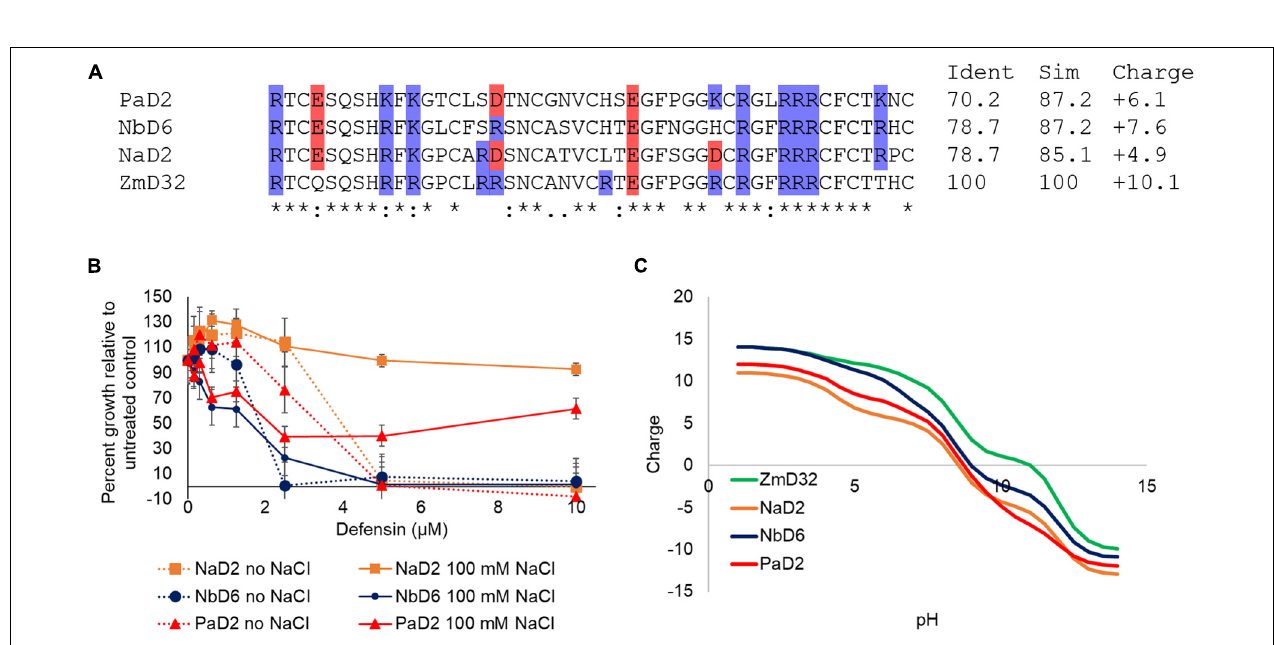
FIGURE 8 | Activity of defensins with similar sequences to ZmD32 is related to the charge on the defensin. A query of the defensins database for sequences that were highly similar to ZmD32 returned three candidates, NaD2, NbD6, and PaD2. (A) A sequence alignment of these three defensins was generated using Clustal Omega (www.ebi.ac.uk/Tools/msa/clustalo/). The symbol “ ∗ ” indicates amino acids common to all three sequences and “:” indicates amino acids with strongly similar properties and. amino acids with weakly similar properties. The percent identity and similarity to ZmD32 calculated using the Ident and Sim tool in the Sequence Manipulation Suite (http://www.bioinformatics.org/sms2/) (Stothard, 2000) is listed next to each sequence. Positively charged residues are highlighted in blue, negatively charged residues in red. (B) Activity of NaD2 (orange), NbD6 (purple), and PaD2 (red) against C. albicans in 1 / 2 PDB with (solid lines) and without (dotted lines) the addition of 100 mM NaCl. All of the defensins were active in medium with no added NaCl. In medium with 100 mM NaCl NbD6 retained activity, PaD2 had some activity but this plateaued at around 50% inhibition and NaD2 was inactive. Values are the average of three parallel replicates, error bars are standard deviation. Data is representative of three biological replicates. (C) The predicted charge of the three defensins along with ZmD32 was calculated using PROTEIN CALCULATOR v3.4 (http://protcalc.sourceforge.net/) and graphed vs. pH value.